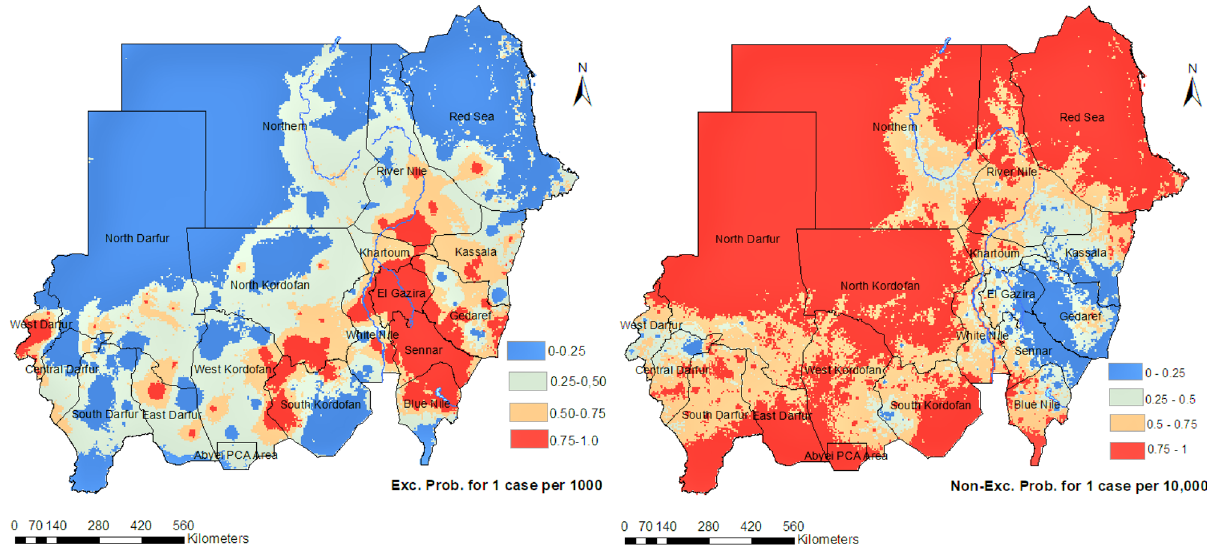
Figure 3. The posterior probability that the incidence cases of the P. falciparum malaria in Sudan exceeds 1 case per 1000 Person-Year-Observed (left panel) and does not exceed 1 case per 10,000 Person-Year-Observed (right panel) in each pixel based on our spatiotemporal Bayesian model fit. These maps were created in ArcGIS (https:// www. arcgis. com) using the ArcMap